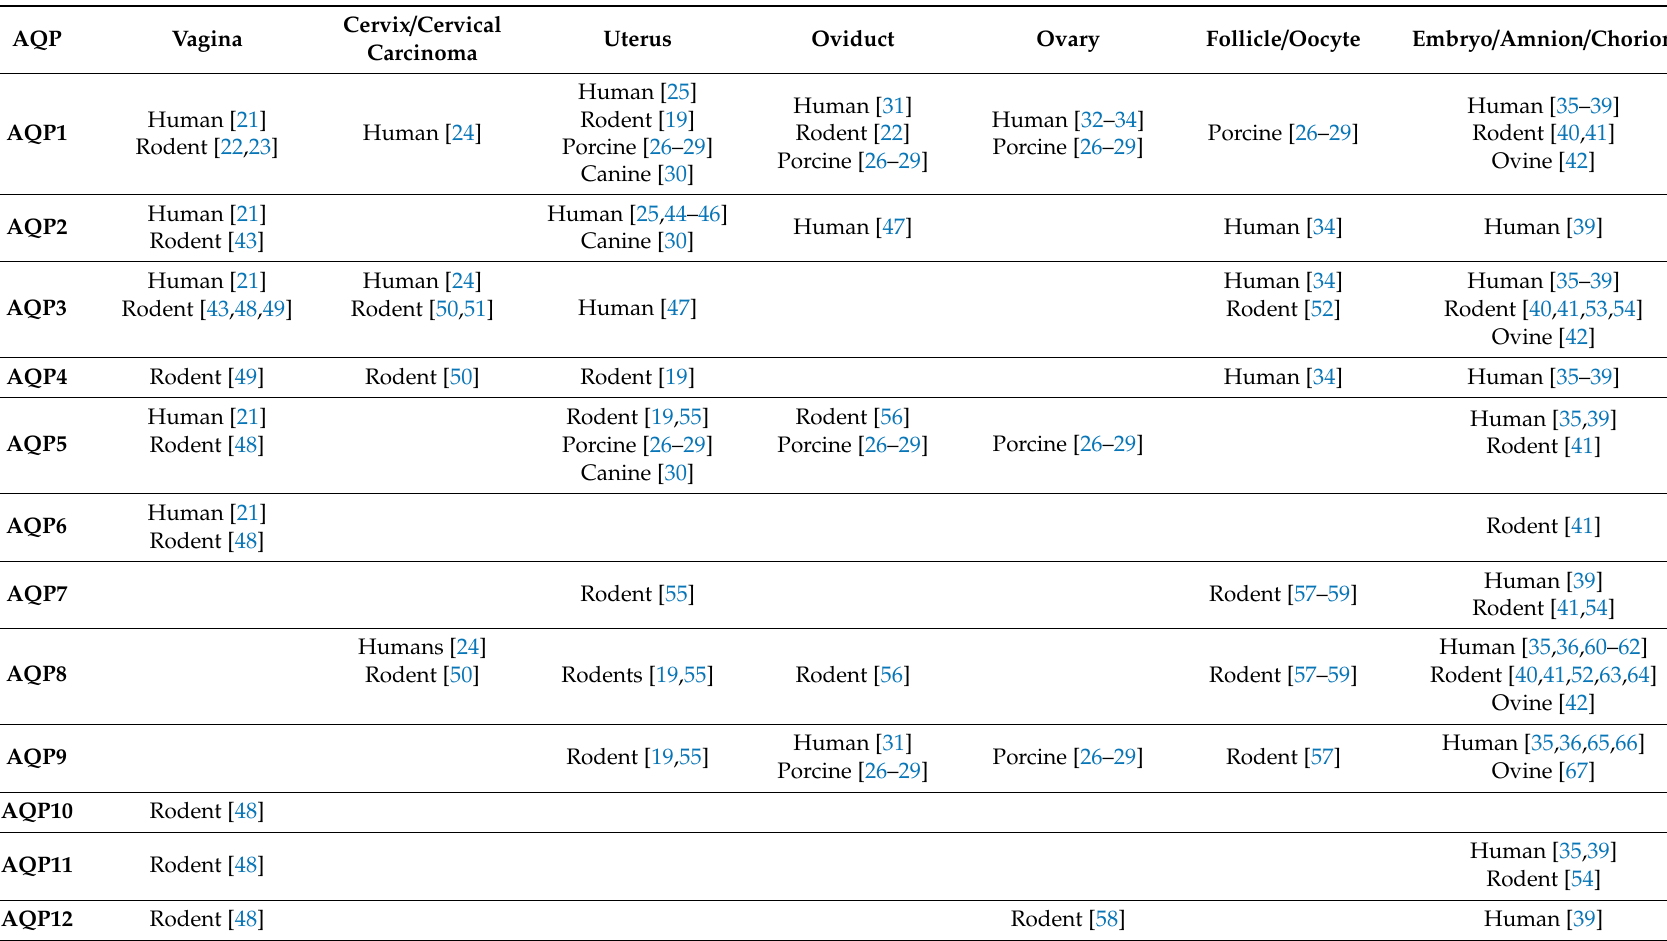
Table 1. Overview of the expression of aquaporins (AQP) at mRNA and / or protein levels in the female reproductive tract of di ff erent mammalian species. Numbers in brackets indicate the